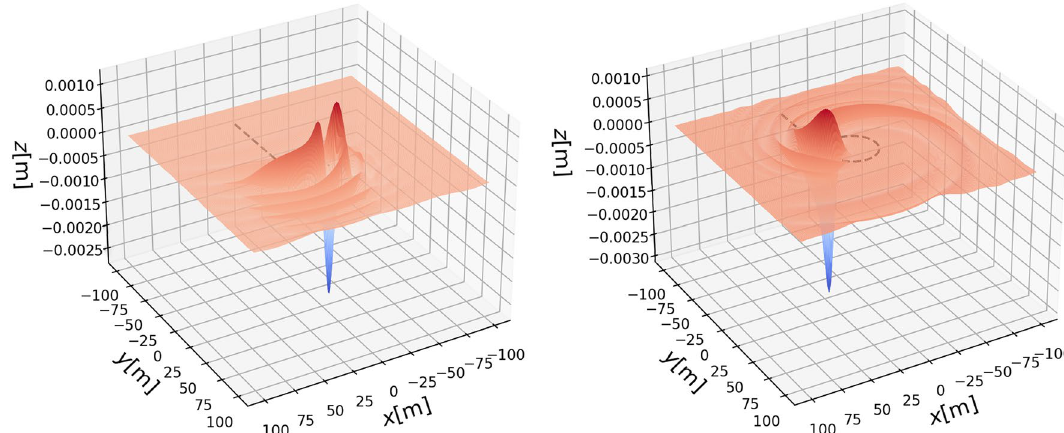
6.5 s. Right panel: Three-dimensional wave pattern =